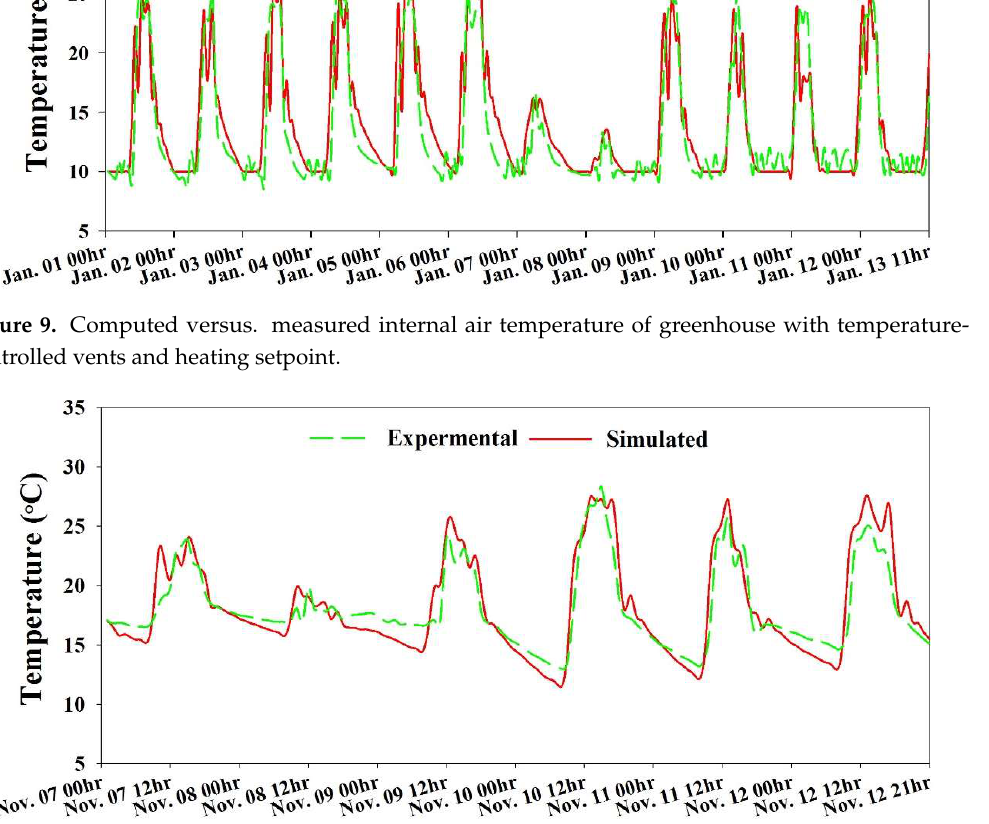
Figure 10. Computed versus. measured internal air temperature of greenhouse with temperature controlled naturally ventilation and thermal screen.